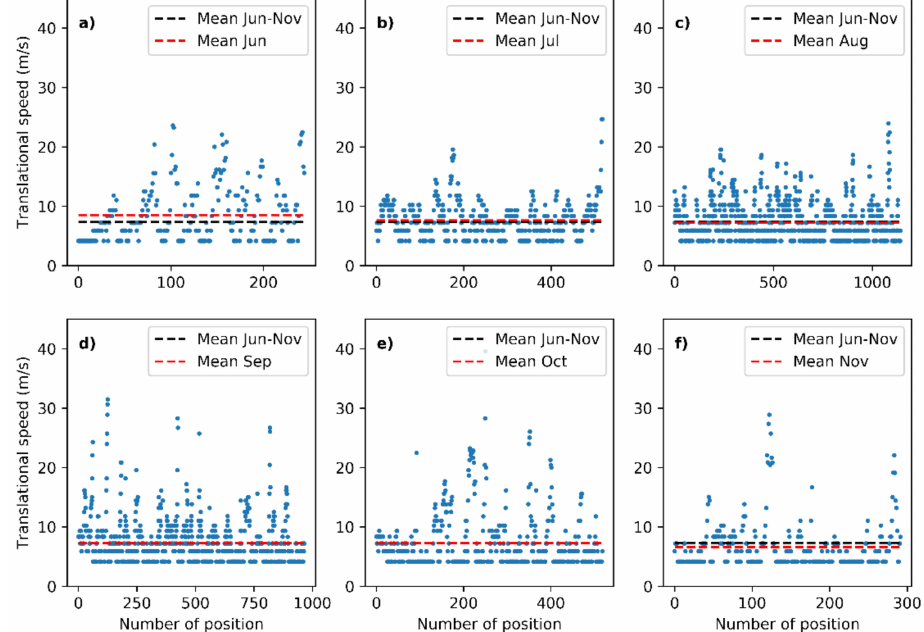
Figure 10. Translational speed for each TC (blue dots) that a ff ected Cuba for each month from June ( a ) to November ( f ), the average translational speed for the month (dashed red line) and the mean for June–November (dashed black